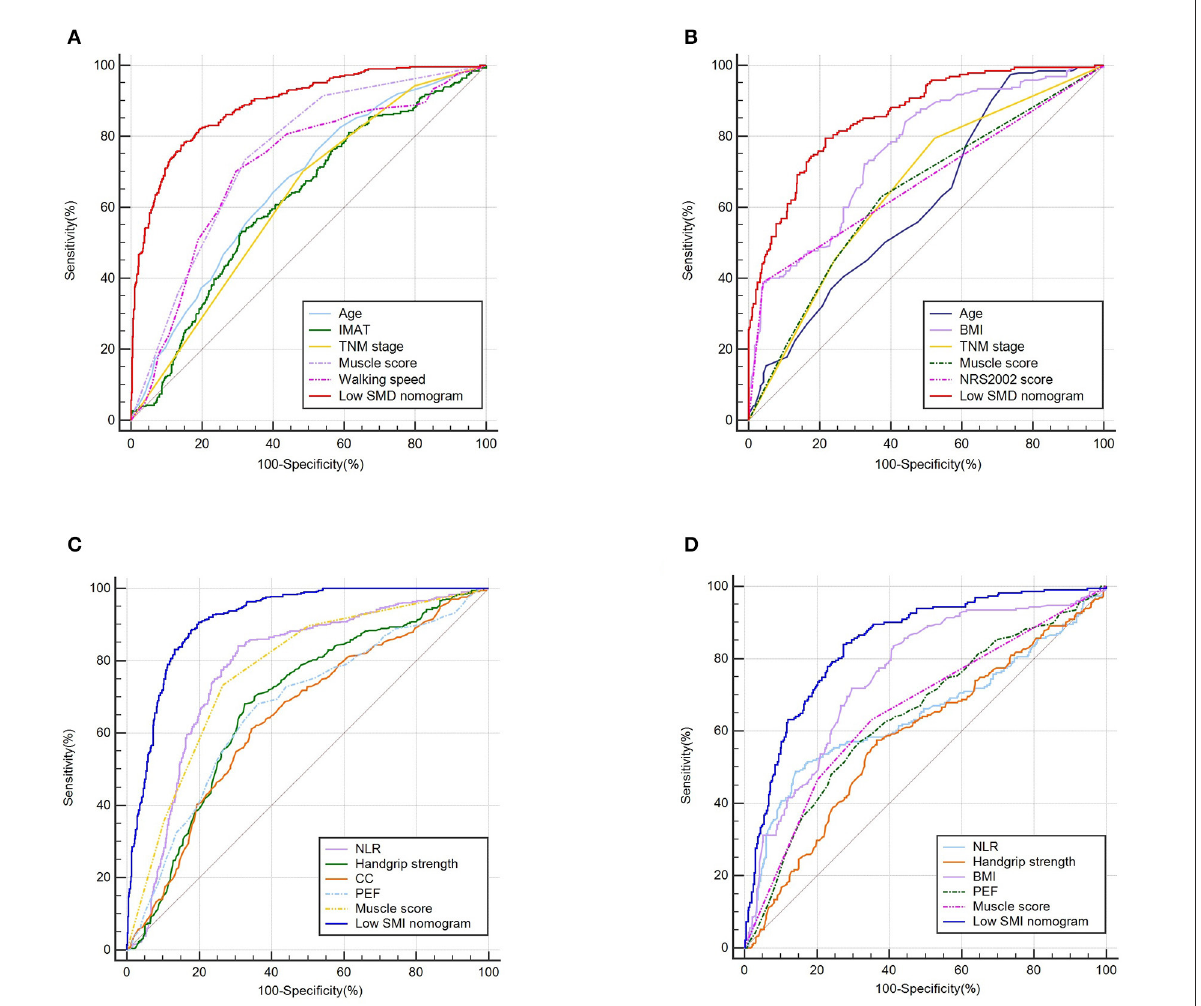
FIGURE5 The ROC curves of predictive factors and nomograms for predicting low SMD and low SMI based on the training ( n = 1,005) and validation ( n = 632) cohorts. The ROC curves of predictive factors and nomograms for predicting low SMD based on the training (A) and validation (B) cohorts. The ROC curves of predictive factors and nomograms for predicting low SMI based on the training (C) and validation (D)